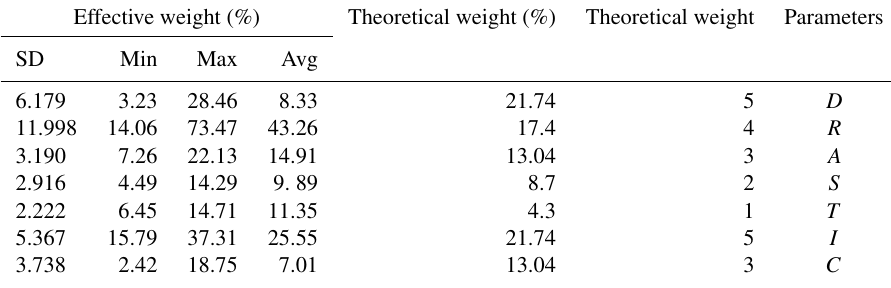
Table 9. Statistical results of SPSA in the DRASTIC index. Effective weight (%) Theoretical weight (%) Theoretical weight Parameters